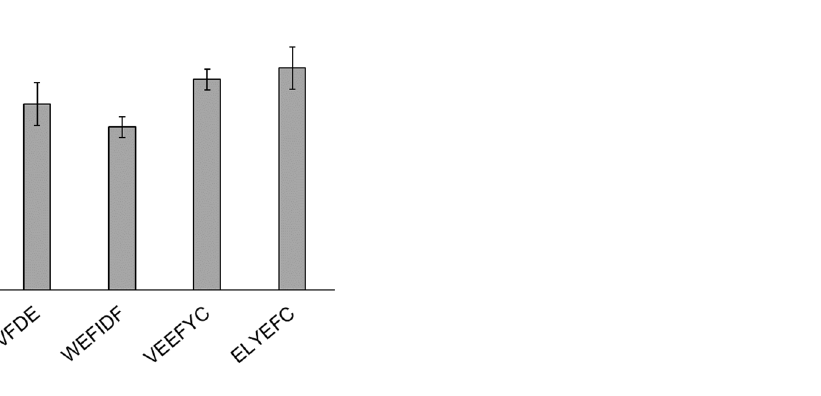
Figure 4. Amount of the five peptides released at pH 7. First all peptides were adsorbed to HT silica gel at pH 2. IFIYDE could not tested because it did not dissolve under at pH 2.